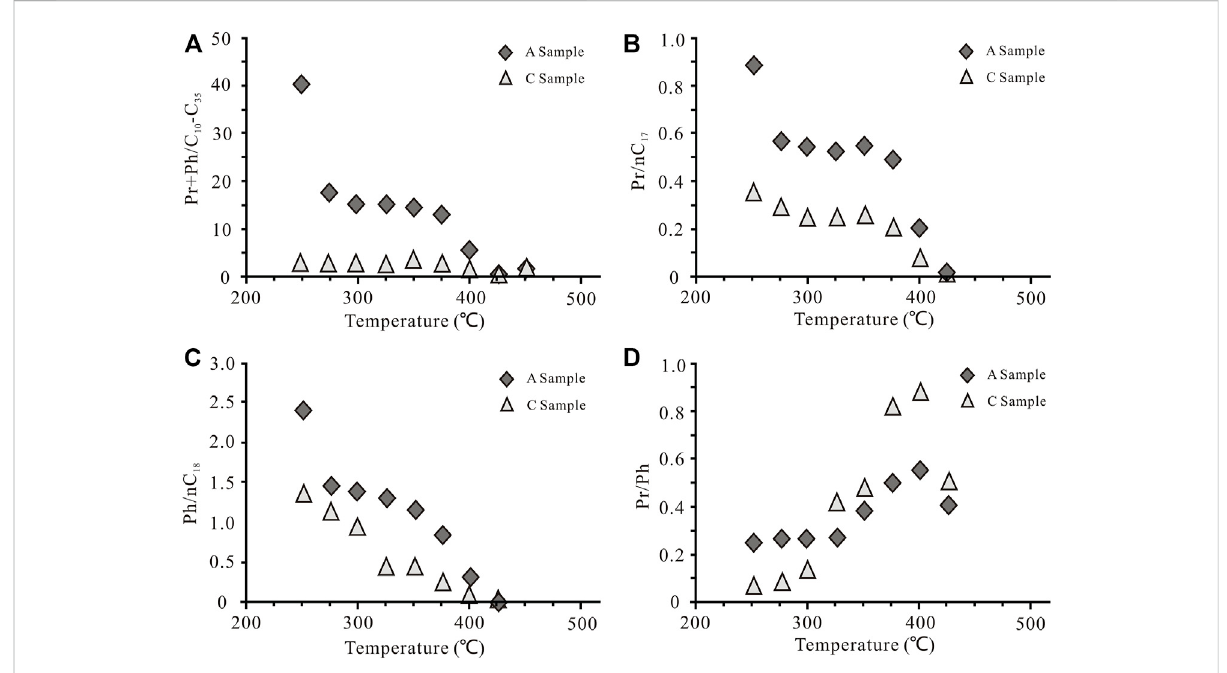
FIGURE 5 Parameter comparison of biomarkers [ (A) (Pr+Ph)/nC 10 ‒ 35 ; (B) Pr/nC 17 ; (C) Ph/nC 18 ; (D)